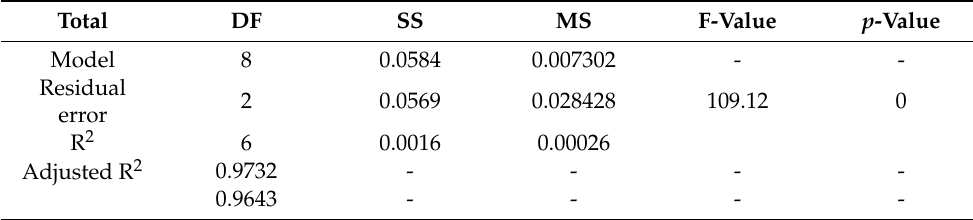
Table 5. ANOVA table.